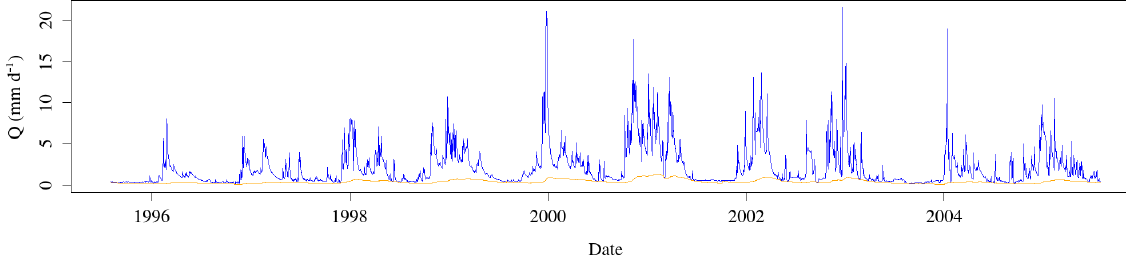
Figure 6. Hydrograph separation of the Virène River in Vire-Normandie for 1995–2005.